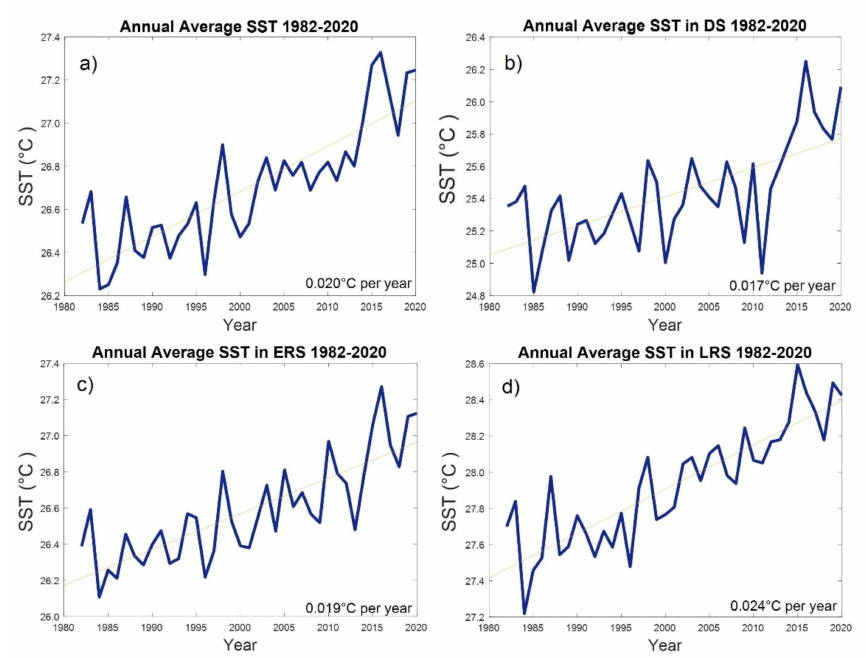
Figure 2. Summary of regional (spatial) averaged trends from 1982–2020: ( a ) annual regional average SST time series for the Caribbean and surrounding region, ( b ) regional average of SST in the Dry Rainfall Season, ( c ) regional average of SST in the Early Rainfall Season, and ( d ) regional average of SST in the Late Rainfall Season.